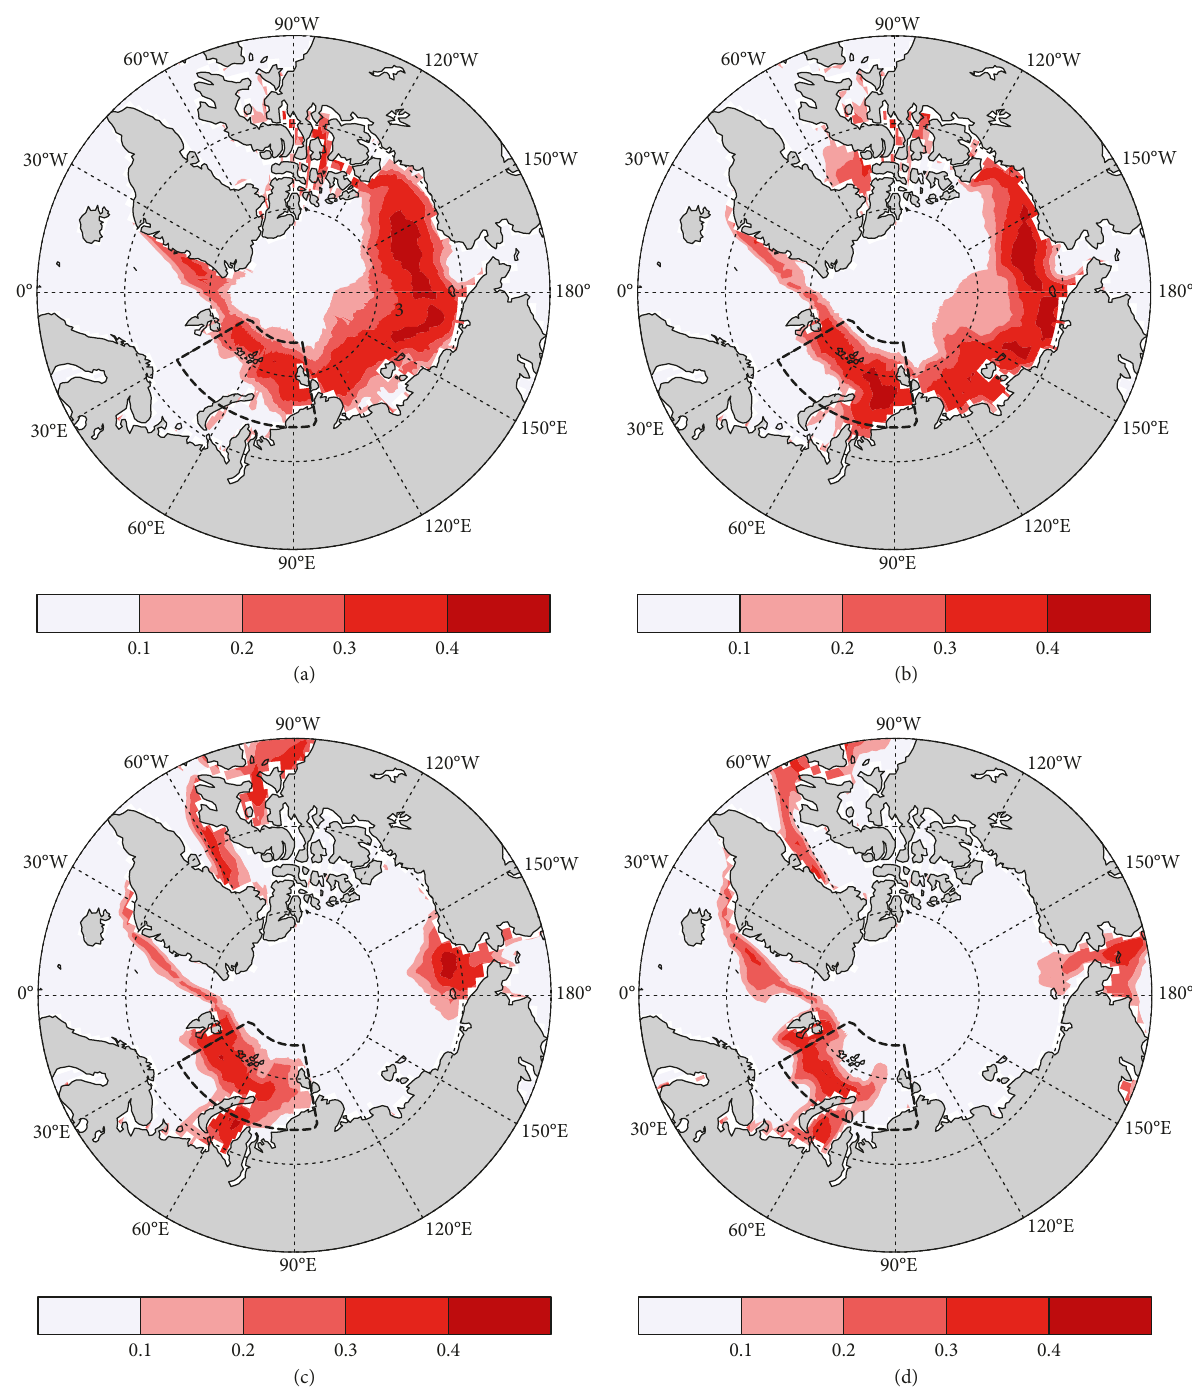
Figure 1: Standard deviations of the Arctic sea ice concentration data for September (a), October (b), November (c), and December (d) from 1979 to 2018. The black dashed box denotes the Barents Sea and the Kara Sea